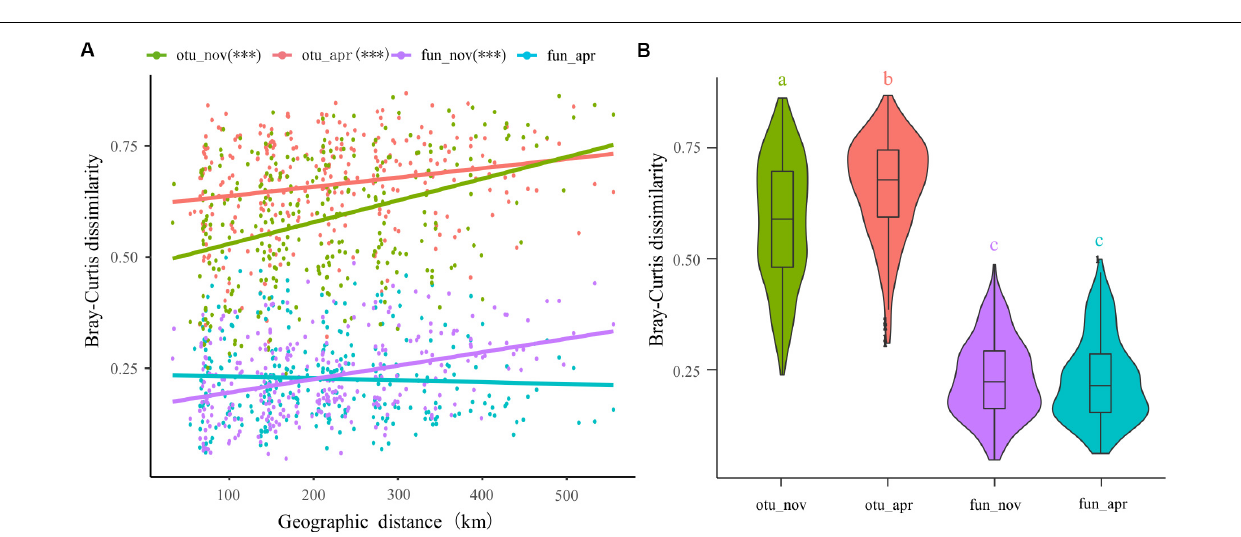
observed in the bacterial functional composition in November (adjusted R 2 = 0.142, p < 0.001) but not in April (adjusted R 2 = -0.001, p = 0.395) ( Figure 7A